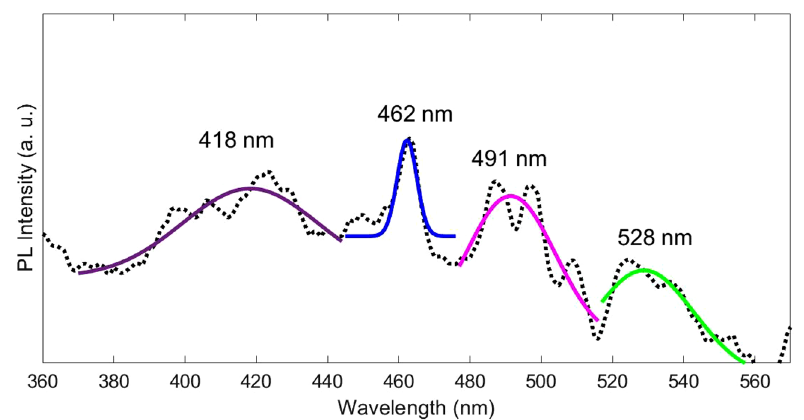
Figure 12. The PL spectra of Si/NiO heterojunction with gaussian fitting of four emissions.